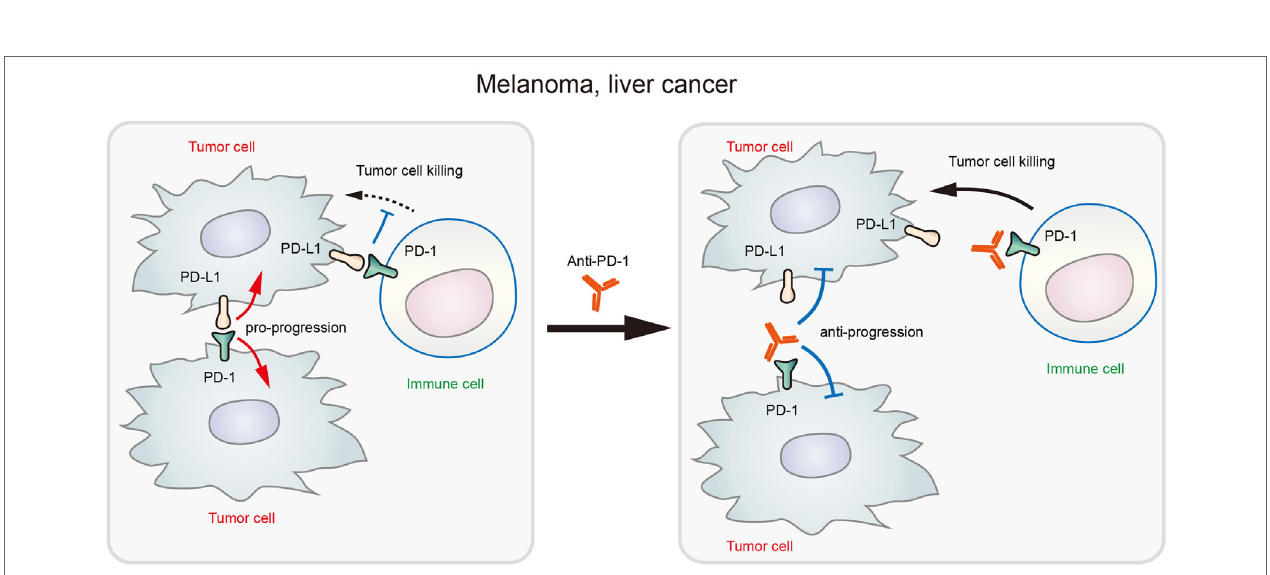
FiGURe 2 | Schematic diagram showing that blockade of tumor-intrinsic programmed death 1 (PD-1) suppresses tumor growth in melanoma and liver